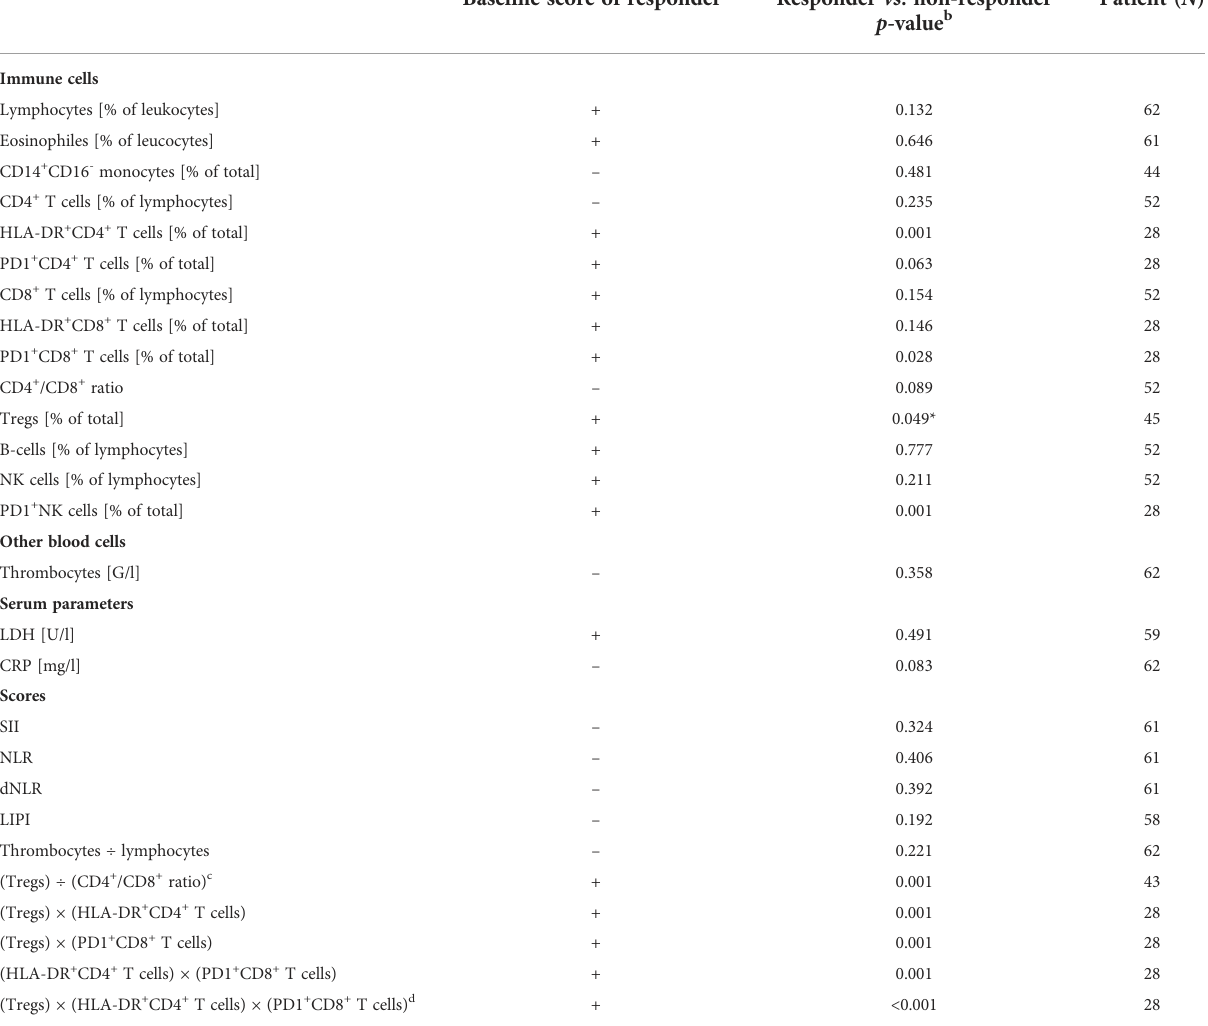
TABLE 2 Immune cells, other laboratory markers, and scores in correlation with response to